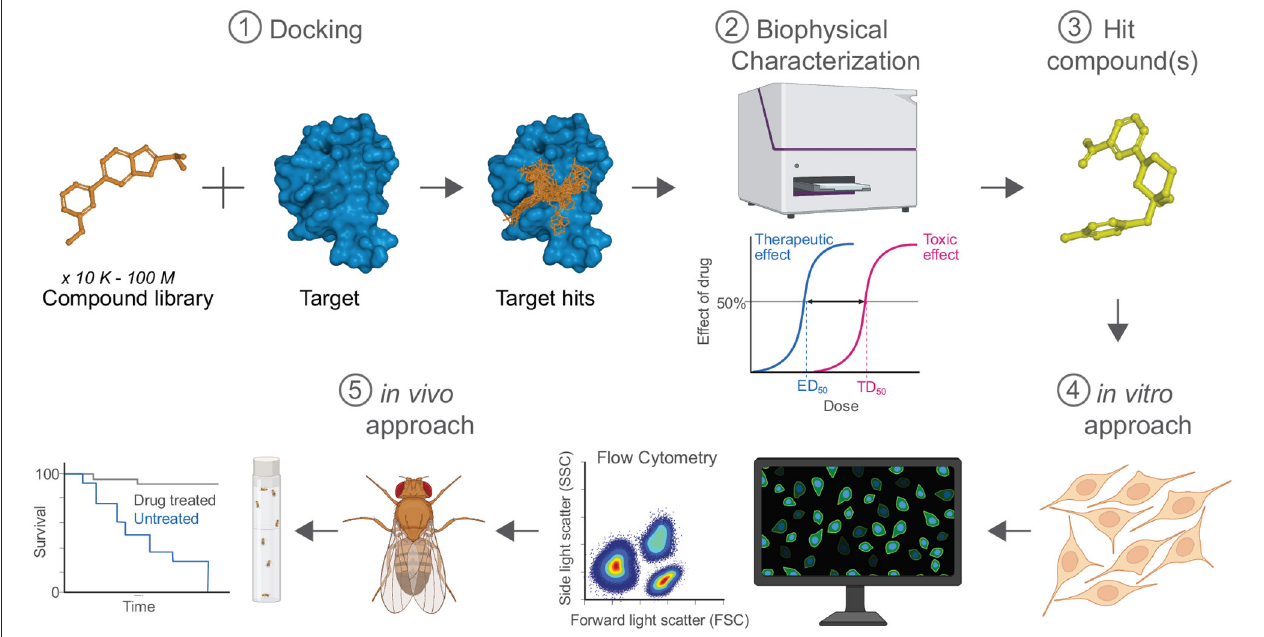
FIGURE 2 | Target-directed approach in the drug discovery pipeline for ND therapies. Building upon on the individual strengths of multiple techniques, this integrated approach synergistically accelerates the identification of compounds for clinical development. In silico docking (1) is used to identify potential therapeutic compounds using computer models and mathematical methods. The in-silico leads are further characterized using biophysical methods (2) to assess target:candidate binding, thermodynamics, and pharmacokinetic/pharmacodynamic parameters. Hit compounds (3) are identified and subjected to in vitro screening protocols (4) using the appropriate cell culture conditions, e.g., NSC and neurons from patient-derived tissue samples that are subsequently analyzed using flow cytometry. To assess pre-clinical effects of hit compounds, flies (5) serve as an in vivo animal model of disease. Created with